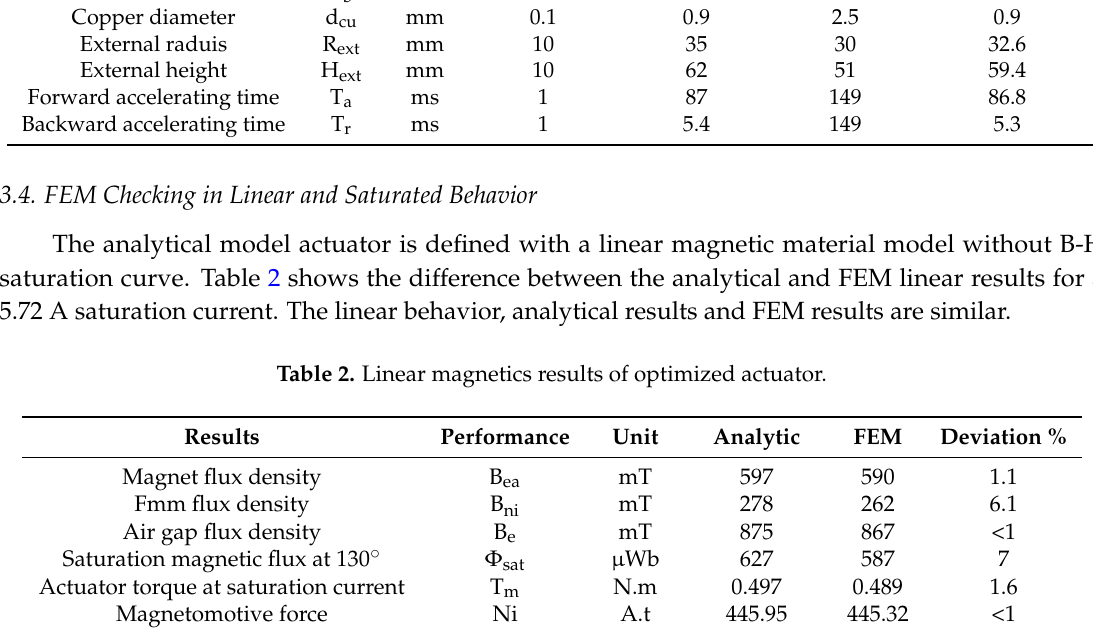
Table 1. Optimized parameter values.